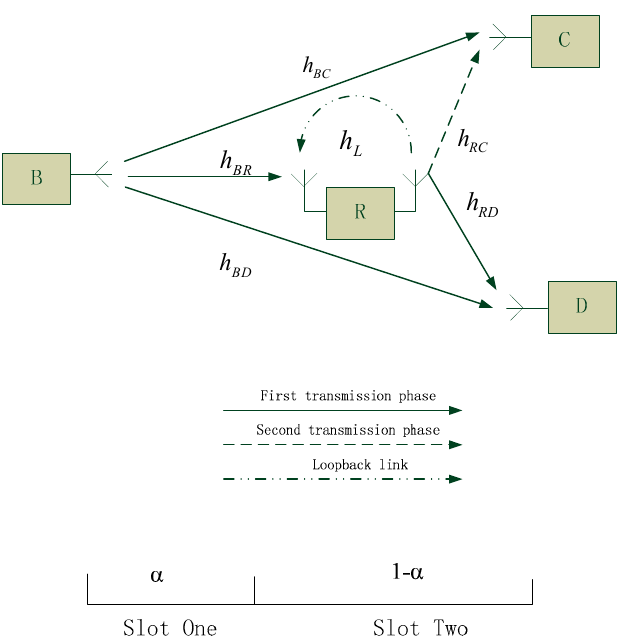
Figure 1. System model for the half-duplex (HD) relay-based device-to-device. (D2D) with slot split factor.